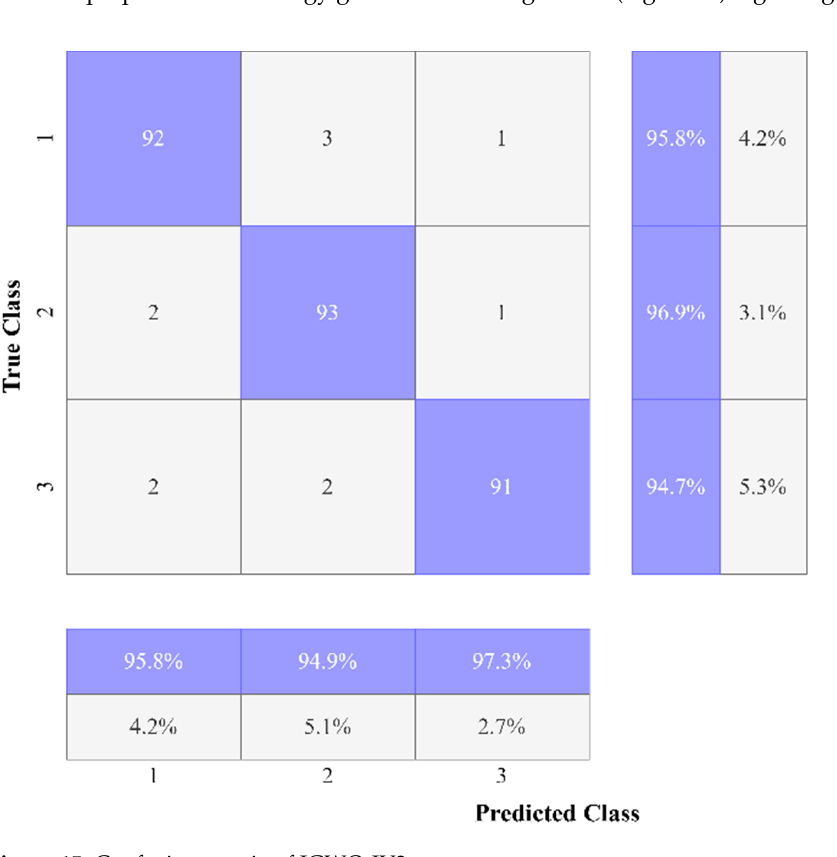
Table 8. A comparison between the proposed work and state-of-the-art models.